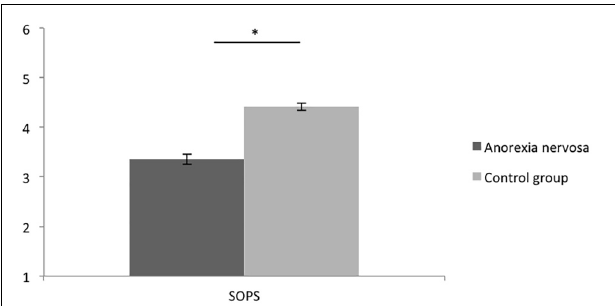
FIGURE 1 | Means of the Personal Sense of Power Scale (SOPS) of women with and without AN. Error bars represent SE.